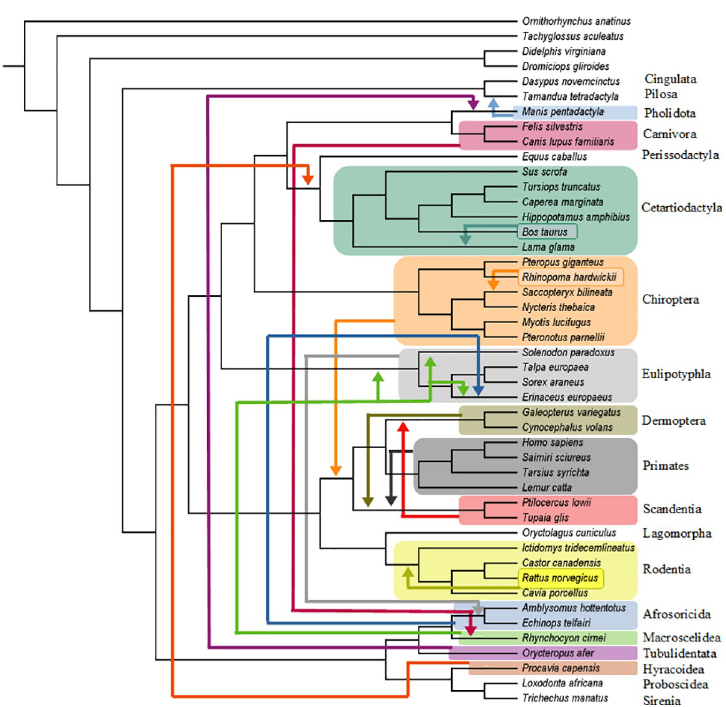
Fig 2. Summary of molecular scaffold + hypothetical predicted ancestors + fossil taxa analyses. Summary of the pseudoextinction results for the O’Leary et al. [31] data set for one of our seven sets of analyses (molecular scaffold + hypothetical predicted ancestors + fossil taxa). Orders that were recovered in phylogenetic positions that conflict with the molecular scaffold are indicated by arrows. All analyses recovered a single most parsimonious tree except for Macroscelidea, which had three most parsimonious reconstructions. Shifts of individual species within orders are also indicated by arrows. Only eight orders (42%) (Proboscidea, Sirenia, Lagomorpha, Perissodactyla, Cingulata, Pilosa, Rodentia, Cetartiodactyla) remained in the correct interodinal position when pseudoextinct.